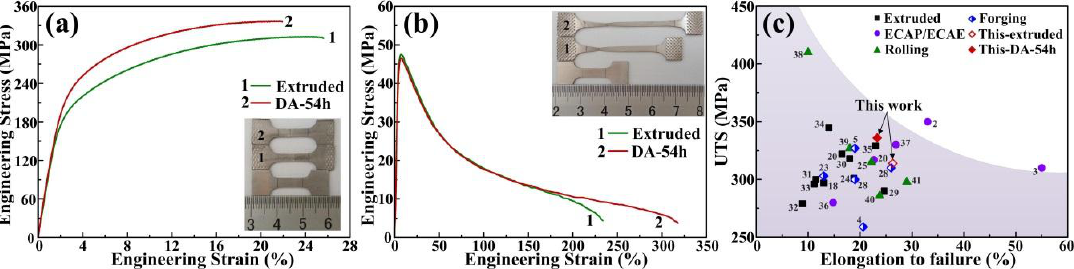
Figure 5. ( a ) Tensile engineering stress-strain curves of the extruded and DA-54h alloy at room temperature and ( b ) at 300 °C (insets: comparison of specimens before and after deformation), ( c ) ultimate tensile strength (UTS) as a function of elongation to failure of AZ61 alloy processed by various methods in the literature for comparison with this work. Table 1. Tensile properties of the extruded and DA-54h AZ61 alloy at room temperature and 300 °C.